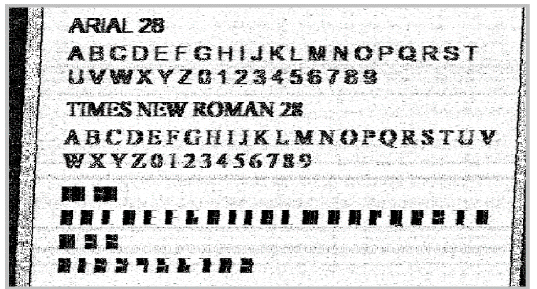
Figure 19. Font 28 with blank spaces: Arial, TNR and secure asymmetrical.